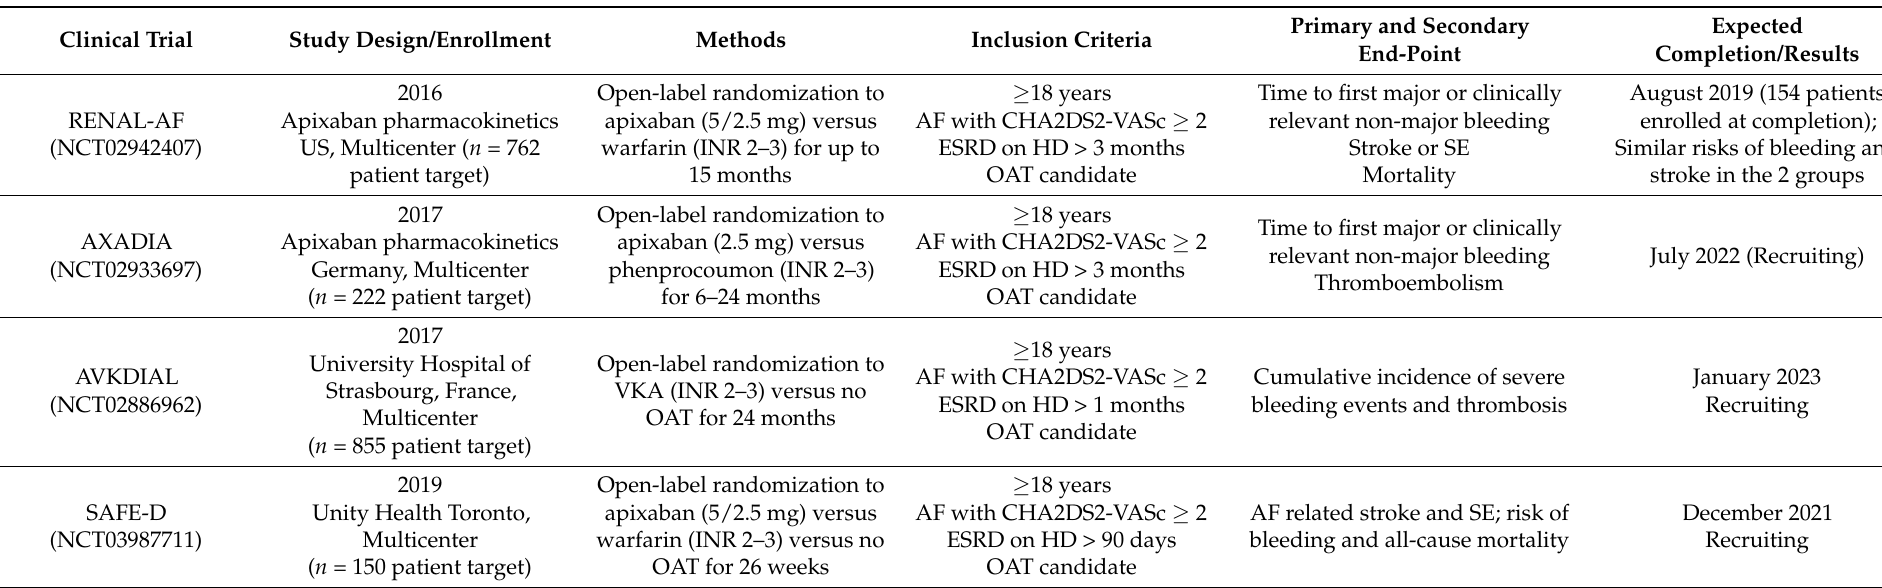
Table 4. Clinical trials evaluating the efficacy and safety of oral anticoagulation in patients with end-stage renal disease and concomitant atrial fibrillation. Clinical